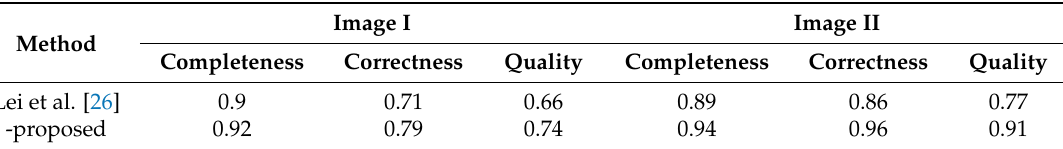
Table 3. Performance of the two road-extraction methods.